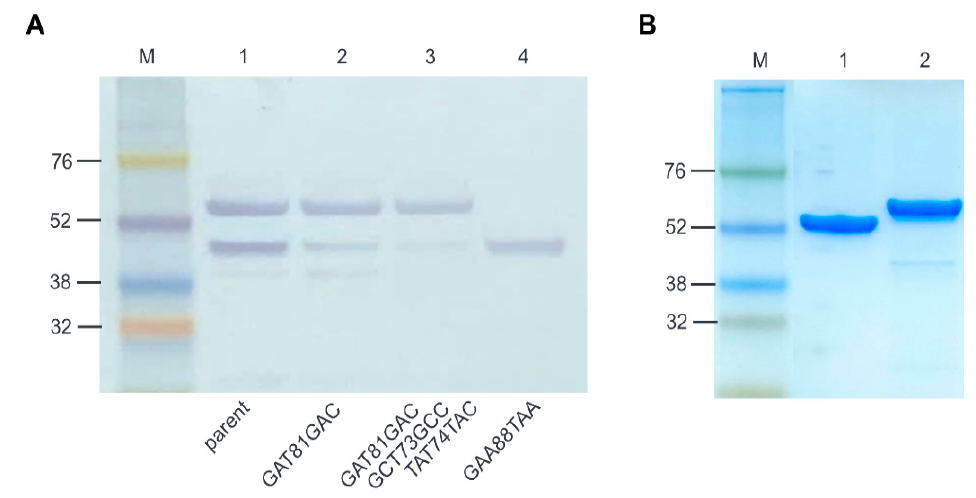
Figure 4. Reduced subprotein by mutation of the innate promoter of ALS2 and purification of ALS2. ( A ) Western blotting of ALS2 expressed from parent and mutated DNA templates. The molecular weight of the 6 histidine-tagged ALS2 is approximately 52.4 kDa and the subprotein is approximately 42.9 kDa after E. coli expression. Lane M: protein molecular weight marker (Amersham™ ECL™ Rainbow™ Marker, Lane 1: ALS2; Lane 2: ALS2 expressed from ALS2-TS-10 gene with GAT81GAC silent mutation; Lane 3: ALS2 to expressed from ALS2-TS-31 gene with GAT81GAC, GCT73GCC and TAT74TAC silent mutations; Lane 4: Subprotein expressed from ALS2-Stop gene with GAA88TAA nonsense mutation. ( B ) SDS-PAGE of purified ALS2 and ALS1 using 4–10% gradient polyacrylamide gel. Lane M: protein molecular weight marker; Lane 1: ALS2; Lane 2: ALS1.